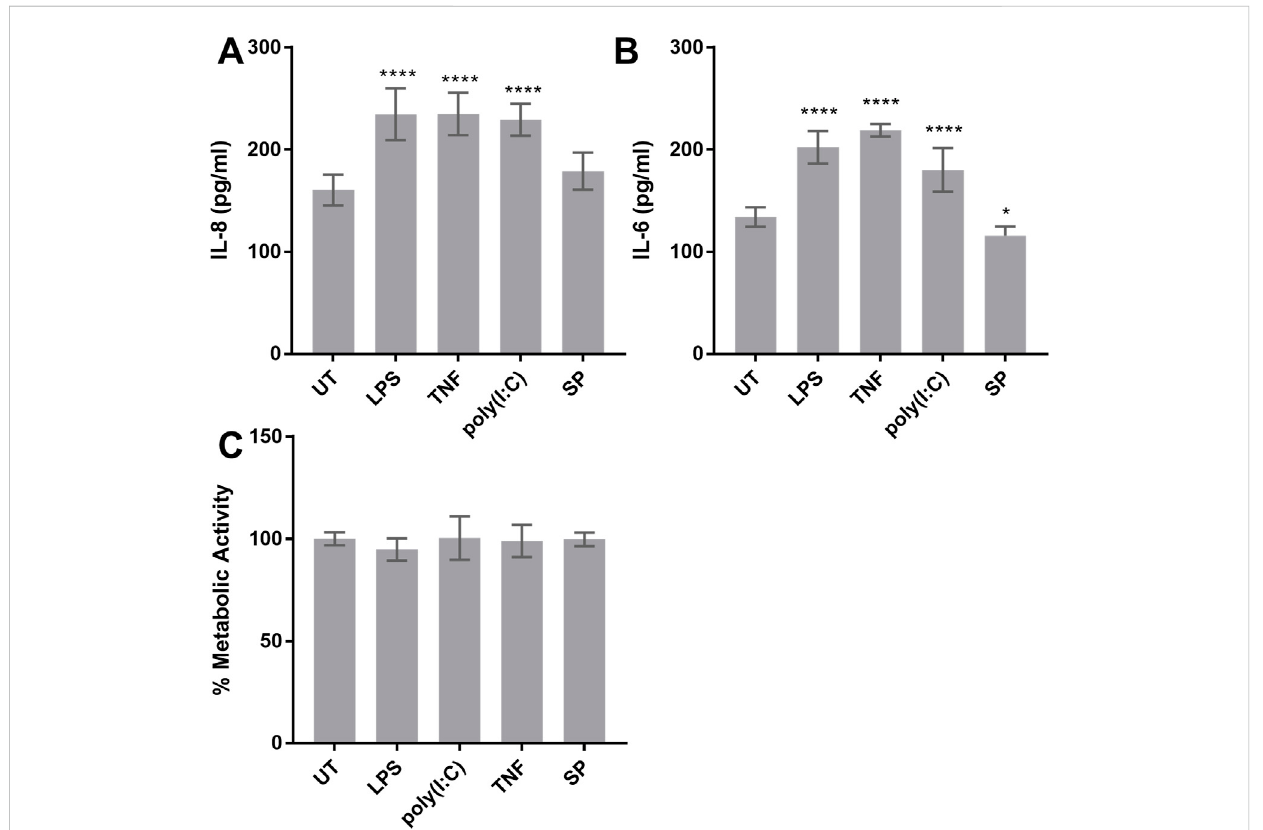
FIGURE 2 Cytokine release and metabolic activity of HMC3. (A, B) HMC3 were stimulated with 1 µg/mL LPS, 0.25 µg/mL TNF, 0.5 µg/mL poly(I:C), 0.5 µg/mL substance P (SP), or left untreated (UT) for 24 h and IL-8 and IL-6 production was measured by ELISA. (C) HMC3 were activated as in (A) and metabolic activity was determined by reduction of XTT. Data are presented as mean ± SEM for n = 3. Statistical signi fi cance was calculated using one-way ANOVA with Dunnett ’ s multiple comparison pot-hoc analysis relative to untreated (UT): p ≤ 0.05 (*), p ≤ 0.0001